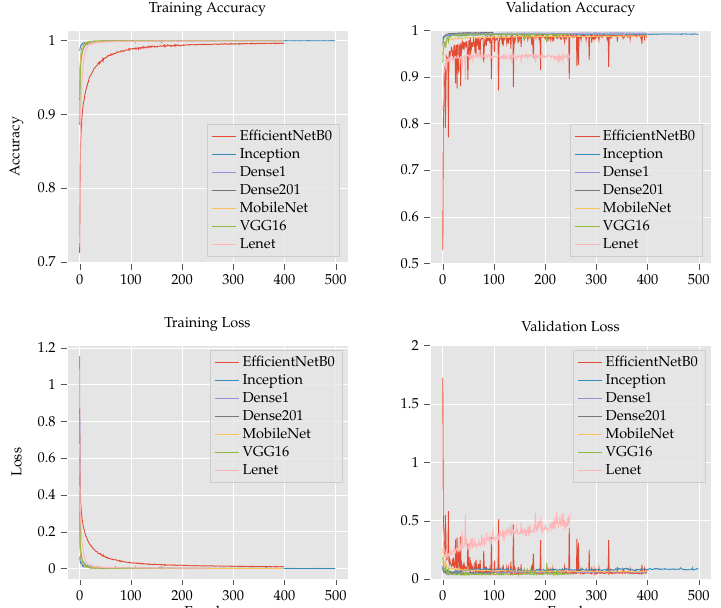
Figure 12. Training and validation learning curves for the custom CNN with various parameters: (i) one dropout layer, (ii) batch normalization + one dropout layer, and (iii) no regularization. All the training and validation loss curves decrease to a point of stability—representing a good fit. The plots show the expected behaviour. Namely, the model with batch normalization and a dropout layer learns the problem quickly as compared to the models with no regularization. In particular, the first model gets up to 90% accuracy in about 25 epochs compared to 100 epochs when no regularization or batch normalization is used.